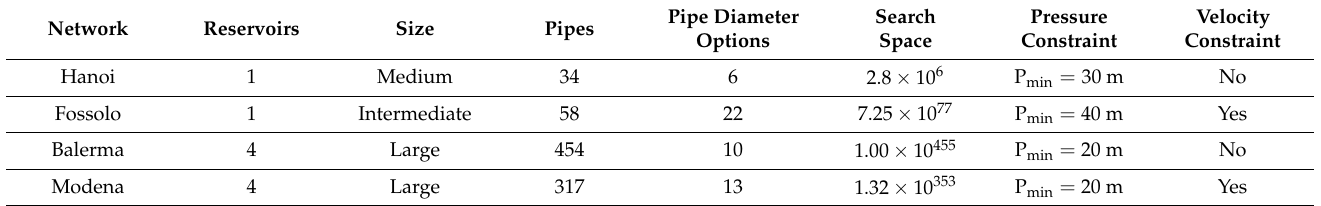
Table 2. Characteristics of the study cases.